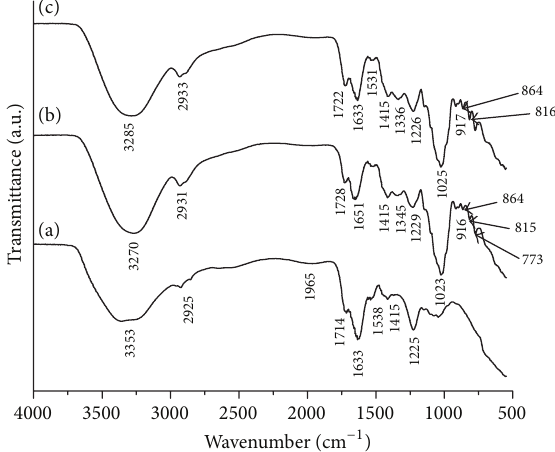
Figure 4: (a) FTIR spectra of ABE. (b) FTIR spectra of gold nanoparticlesaftersynthesis.(c)FTIRspectraofsilvernanoparticles after